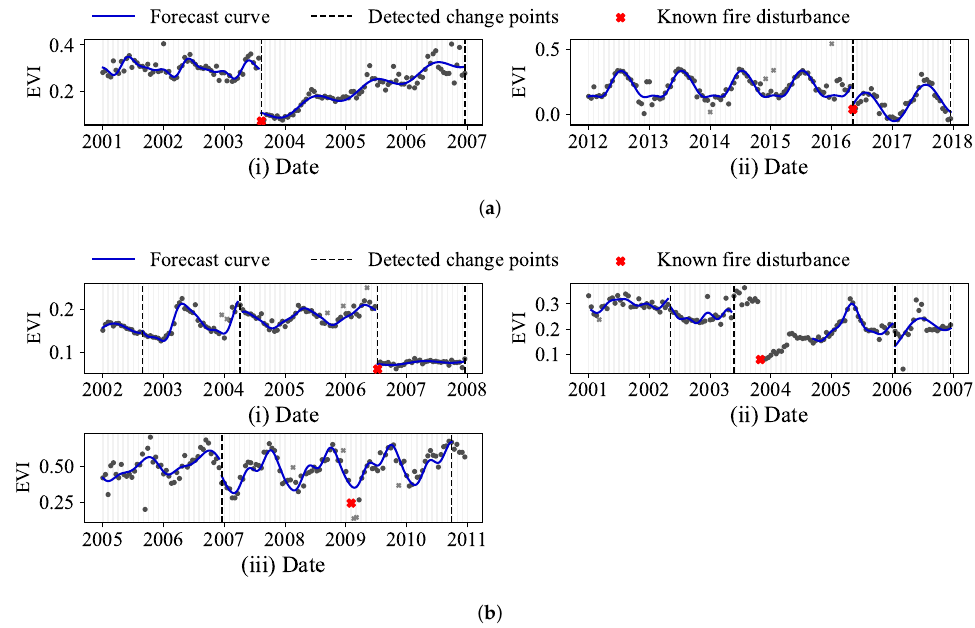
Figure 6. Partial detection results by CCDC model. ( a ) The detection advantages of the CCDC model: ( i ) The moment when the disturbance occurs can be precisely located; ( ii ) the model does not rely on trend components and is good at detecting subtle abrupt changes. ( b ) The detection limitations of the CCDC model: ( i ) Since the data has less noise, the RMSE of the model fit decreases, resulting in the detection of too many change points; ( ii ) detection failure due to fire disturbance during model initialization; ( iii ) the model misinterprets the fire disturbance as